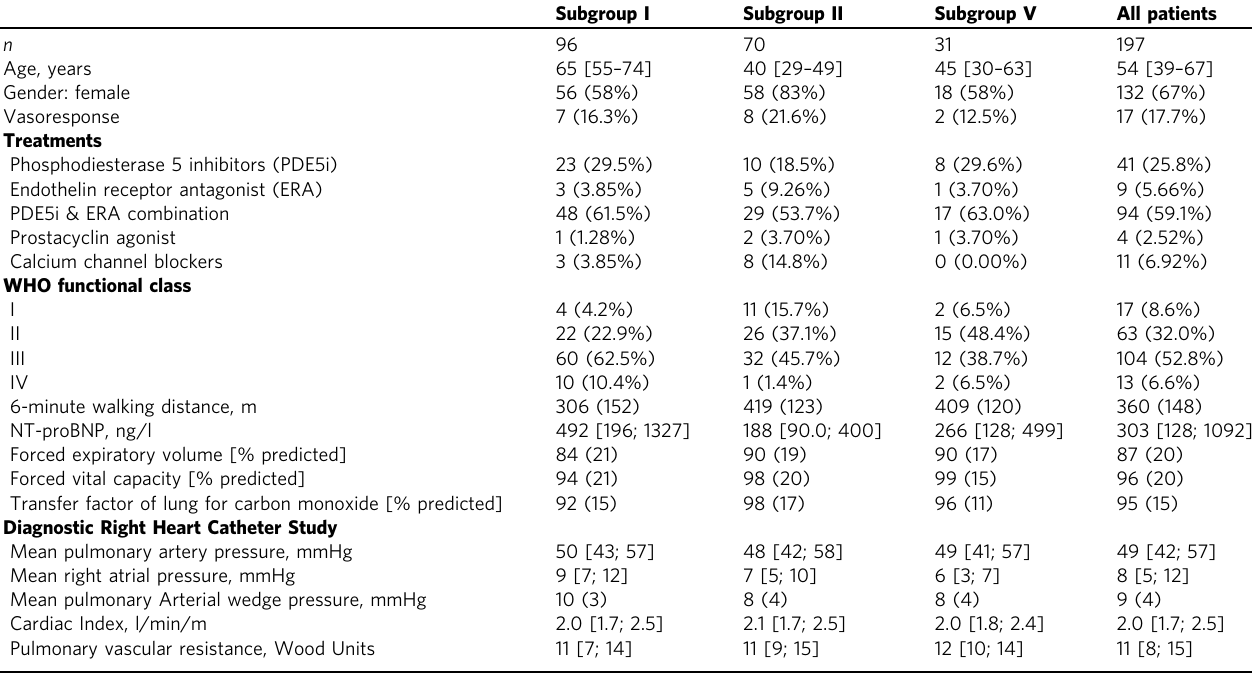
Table 2 Major clinical characteristics of the three subgroups within the validation cohort ( n = 197) at time of